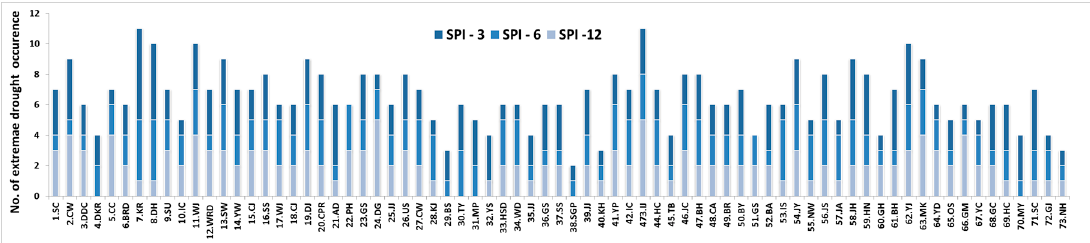
Figure 6. Number of occurrence of extreme drought in each observatory (SPI).